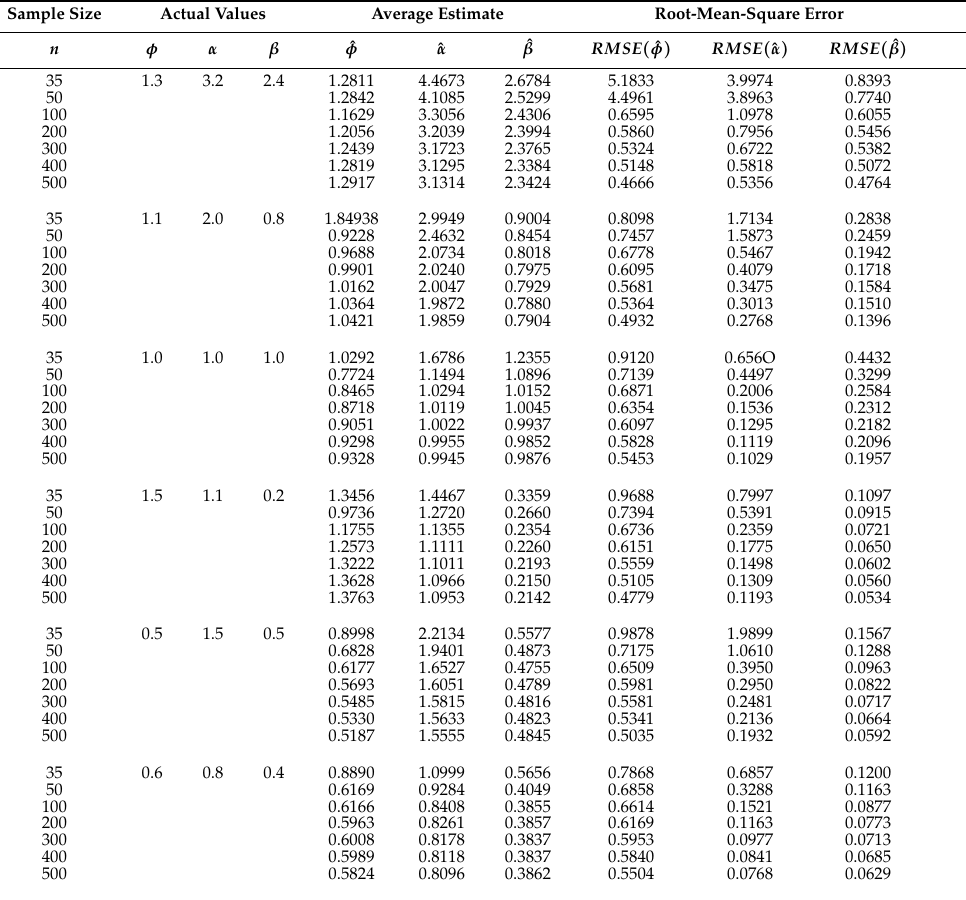
Table 3. Actual values, AEs, and RMSEs of the simulated data from the WOWE distribution for the following parameter configurations with order ( φ , α , β ) : ( 1.3,3.2,2.4 ) , ( 1.1,2.0,0.8 ) , ( 1.0,1.0,1.0 )